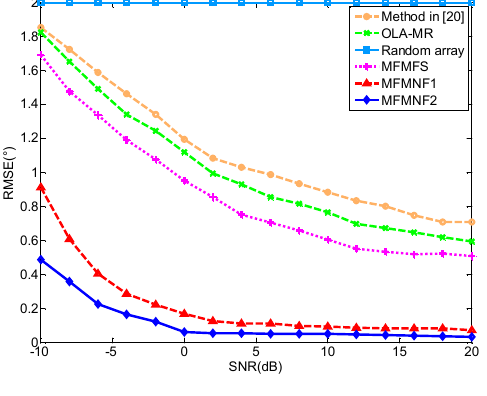
Figure 3. RMSEs versus SNR.